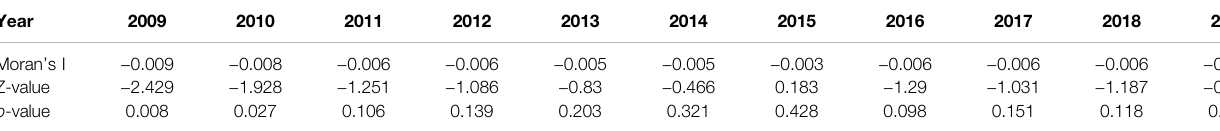
TABLE 6 | Results of the global moran ’ s I test.